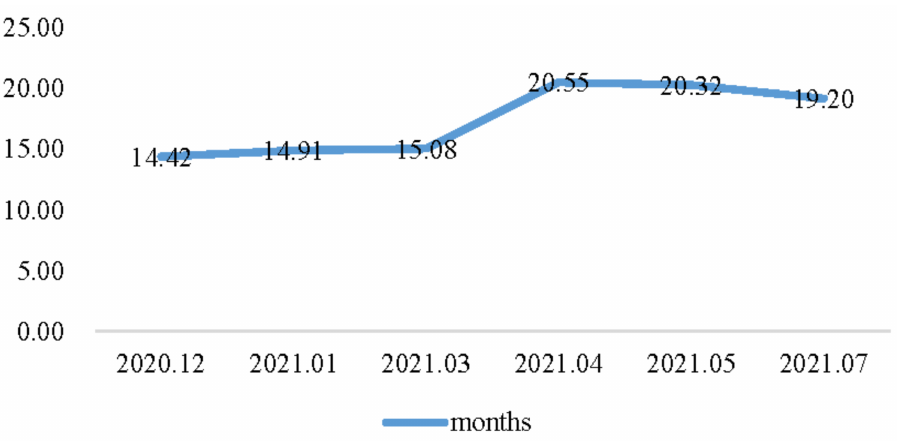
Figure 4. The perceived duration of